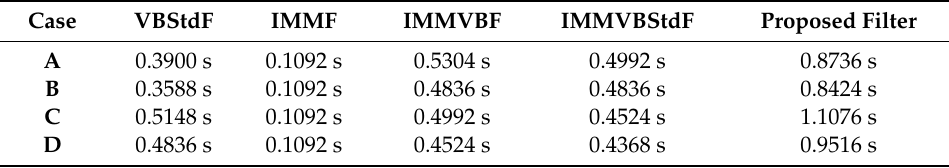
Table 3. Computation time of filters in four